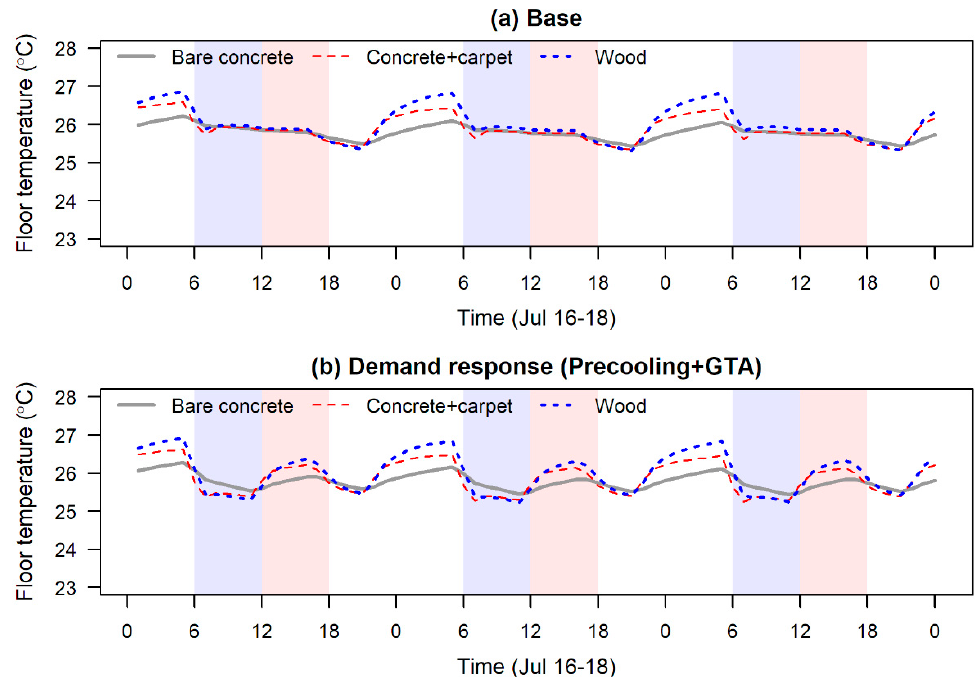
Figure 7. Hourly floor surface temperature of the core zone for three floor configurations: Bare concrete, Concrete + carpet, and Wood under ( a ) Base and ( b ) Precooling + GTA scenarios during 16–18 July in Phoenix, AZ. The blue-shaded area indicates the morning or precooling period while the red-shaded area indicates the afternoon or GTA period.